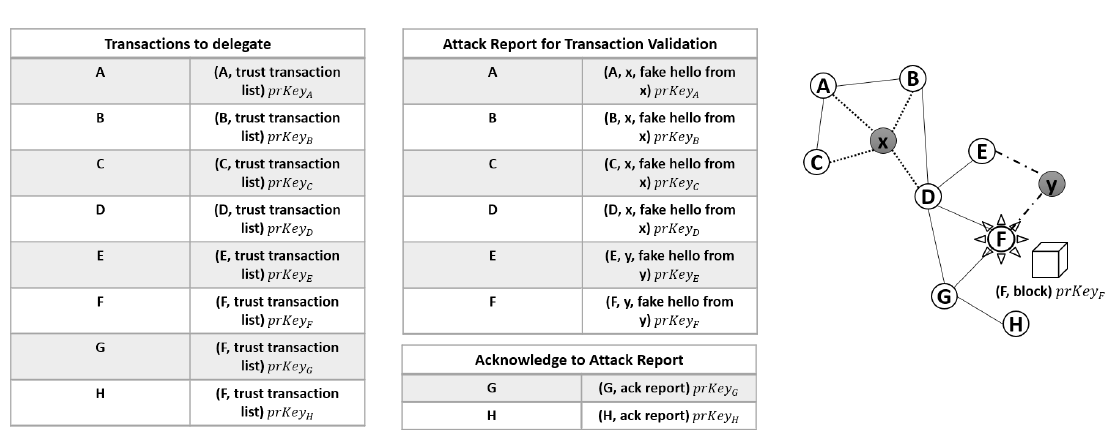
Figure 8. Demonstration of Phase